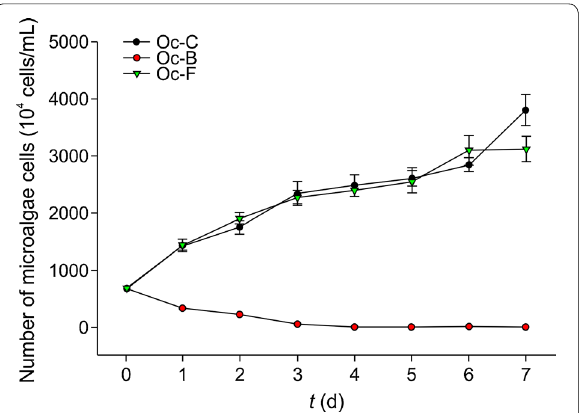
Fig. 1 Effects of CZBC1 on Oscillatoria chlorina growth. Oc‑C: O. chlorina control group; Oc‑B: O. chlorina bacterial suspension group; + Oc‑F: O. chlorina sterile filtrate +